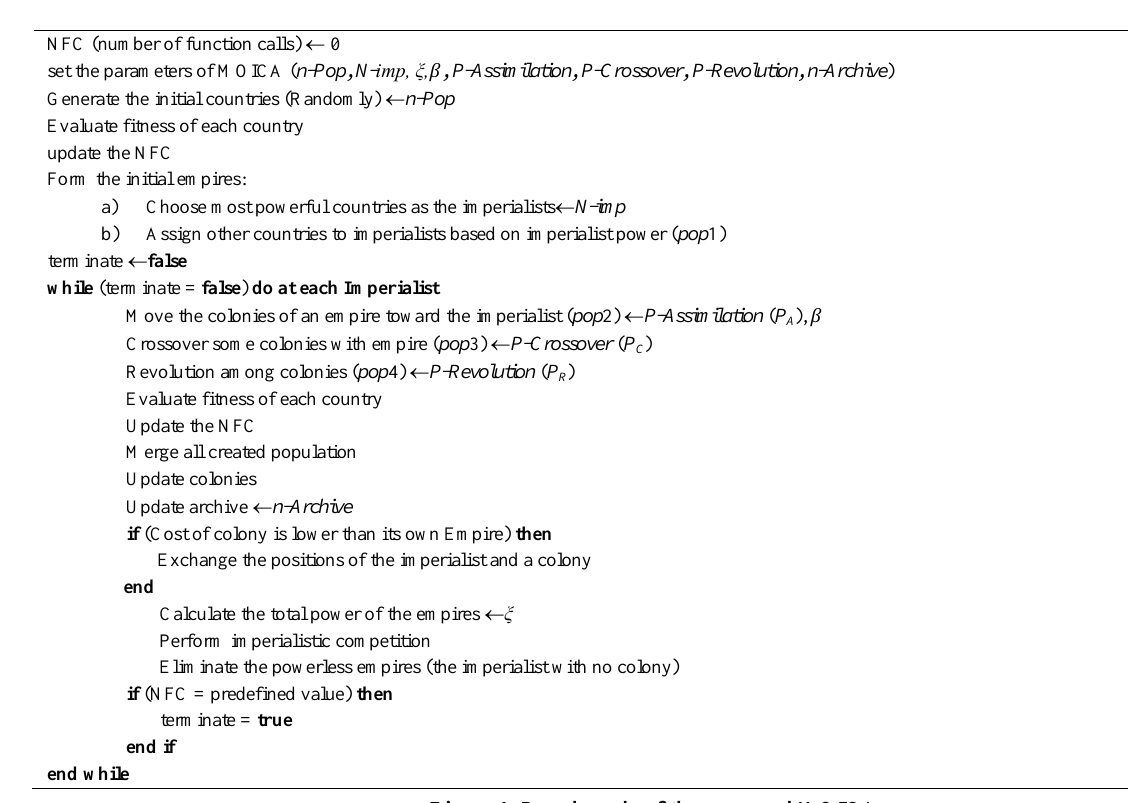
Figure 1. Pseudo code of the proposed